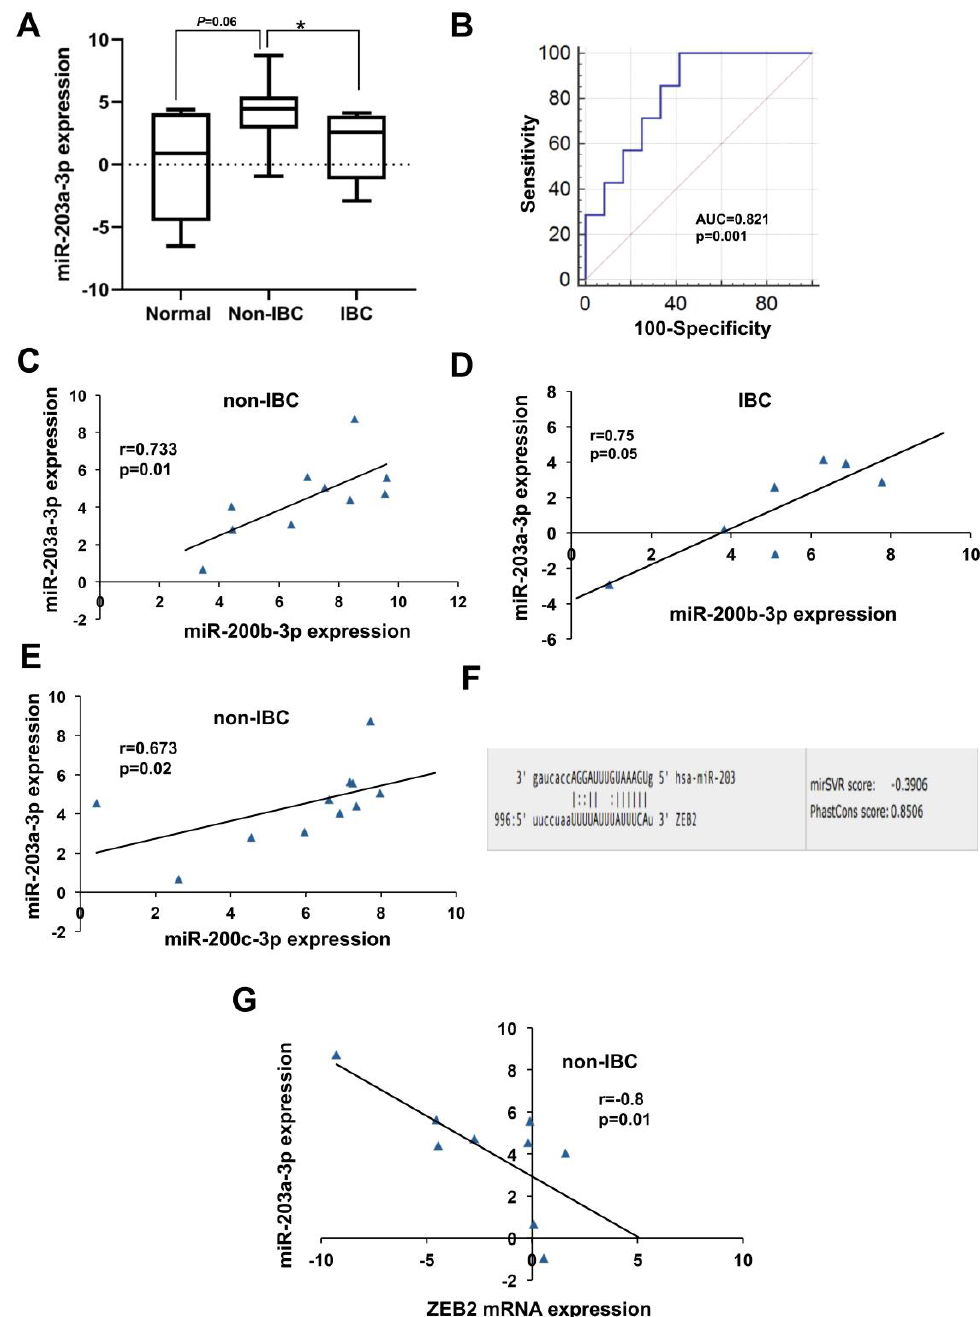
Figure 5. Expression and diagnostic value of miR-203a-3p in carcinoma tissues of non-IBC and IBC in comparison with normal breast tissue samples. ( A ) miR-203a-3p expression levels are significantly repressed in carcinoma tissues of IBC ( n = 7) relative to non-IBC ( n = 12) as determined by qPCR. miR-203a-3p expression is log2-transformed and normalized to values of normal tissues ( n = 5) collected during reduction mammoplasty. * p < 0.05 as determined by Mann-Whitney U-test. ( B ) ROC curve generated using expression levels of miR-203a-3p to discriminate between patients with non-IBC and IBC. ( C ) and ( D ) Spearman’s correlation between expression of miR-203a-3p and miR-200b-3p in carcinoma tissues of non-IBC and IBC, respectively. ( E ) Spearman’s correlation between expression of miR-203a-3p and miR-200c-3p in carcinoma tissues of non-IBC. ( F ) Predicted target sites of the ZEB2 3′UTR aligned with the seed sequence of miR-203a-3p retrieved from the microRNA.org database. ( G ) Spearman’s correlation between expression of miR-203a-3p and ZEB2 mRNA in tissues of